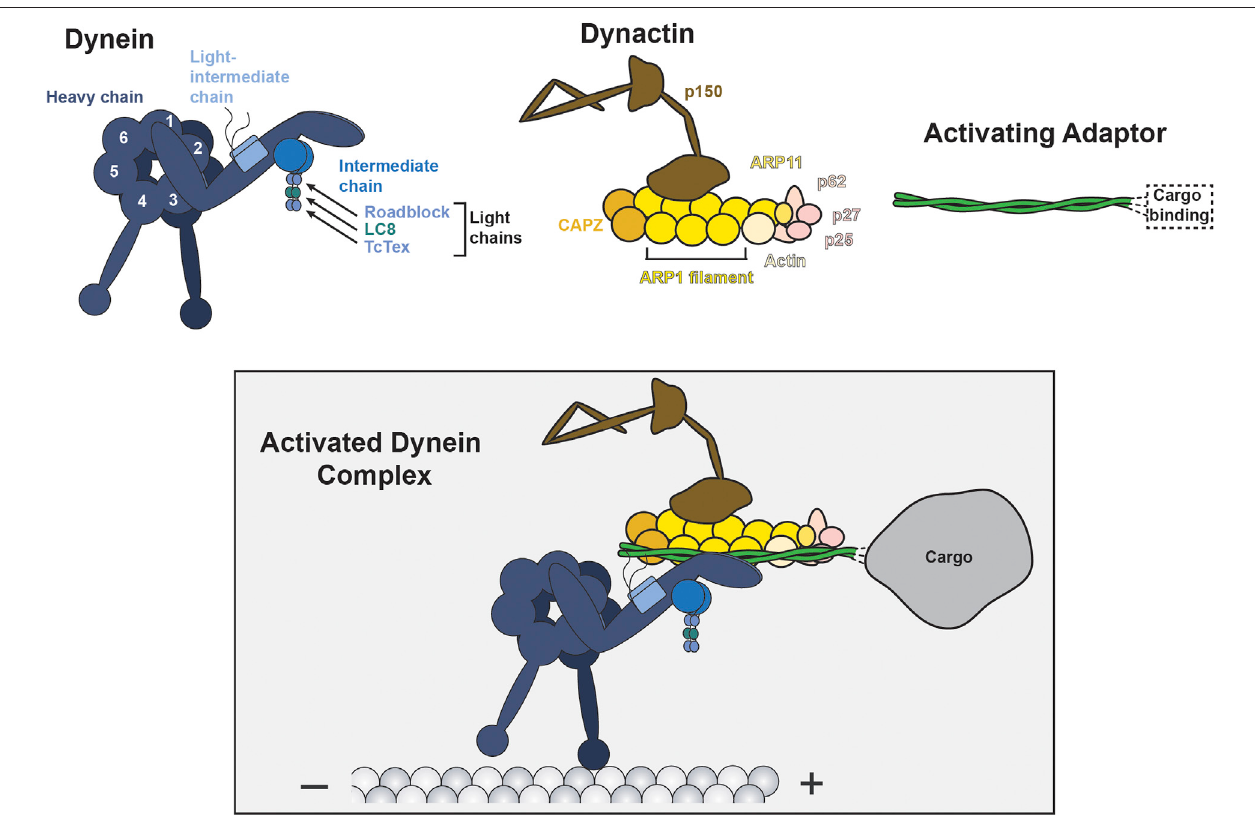
FIGURE 1 | Components of the activated dynein complex. The activated dynein complex (boxed) is the active and processive motile complex driven by dynein motor activity. The activated dynein complex is comprised of dynein (blue), dynactin (yellow/brown/pink), and an activating adaptor (green). Dynein is comprised of six dimeric subunits: heavy chain, intermediate chain, light-intermediate chain, and three distinct light chains. The ATPase motor is contained in the heavy chain and is comprisedofsixseparateATPaseAssociatedwithvariouscellularActivities(AAA)domains(numbered1 – 6),threeofwhich(AAA1,AAA3,andAAA4)arecapableof actively hydrolyzing ATP. Dynein ’ s C-terminal tail extends from AAA6, behind the motor ring, and is not shown in this schematic. Dynactin is a 23-polypeptide complex, with some key subunits indicated. All known activating adaptors are coiled coils, bind dynein and dynactin via domains in the N-terminus, and engage with cargos via domains in the C-terminus (reviewed recently (Reck-Peterson et al.,